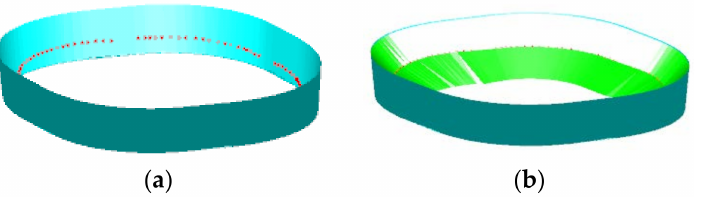
Figure 10. The sheet surface generation: ( a ) starting points of auxiliary line and ( b ) the inclined sheet surface of the first layer.